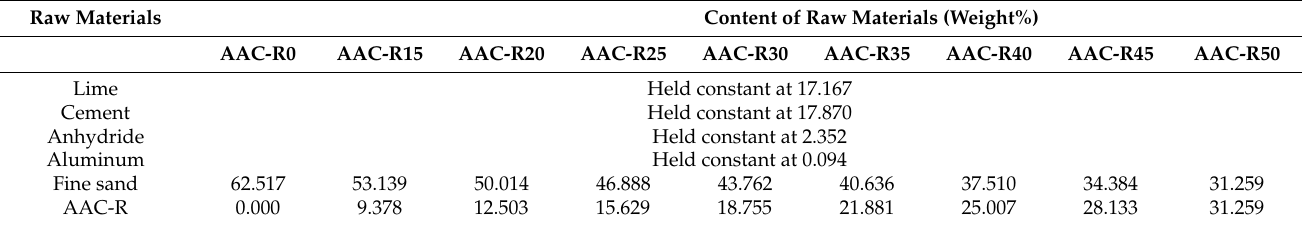
Table 1. Content of raw materials in AAC, showing the variations between the fine wet sand and the recycling powder (AAC-R).